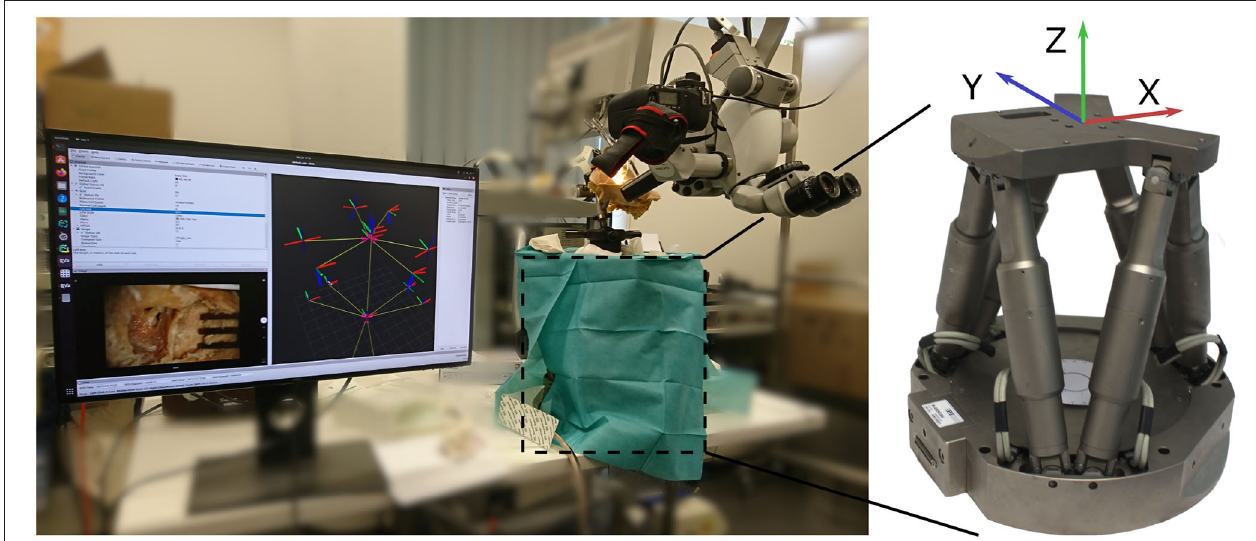
FIGURE 4 | Overview of the evaluation setup. A camera is attached to the side port of a surgical microscope. Below, the phantom is attached to a Stewart platform (covered by drapes). The robot is used for generating precise reference movement data.